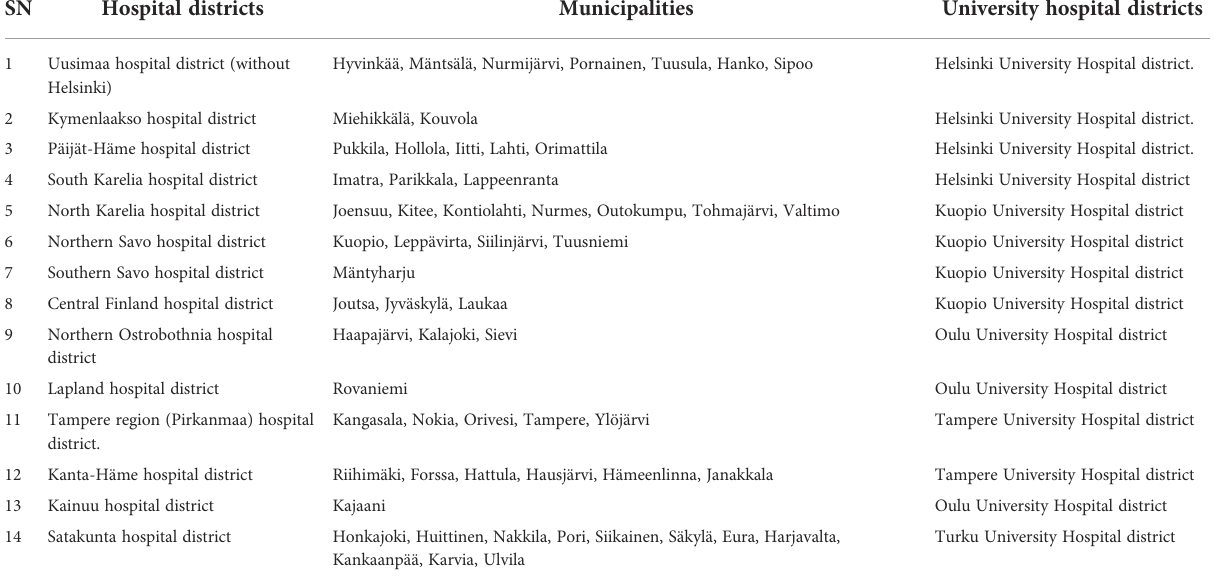
TABLE 3 Radon exposure information in the selected municipalities and hospital districts in Finland.